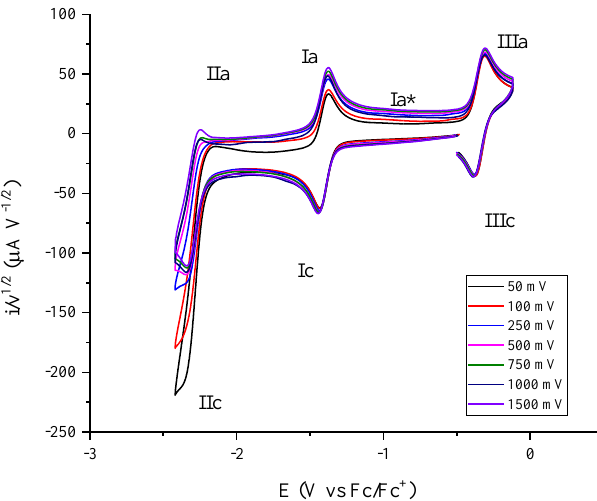
Figure 8. Normalized current cyclic voltammetry of 1 mM [Co II (terpy) 2 ](BF 4 ) 2 solution in MeCN with 0.1 M of TBAPF 6 as supporting electrolyte, bubbled with CO 2 from open-circuit potential to cathodic direction. Glassy carbon disk as a working electrode.